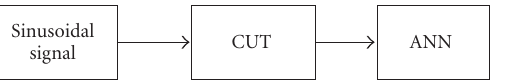
Figure 1: General testing framework.